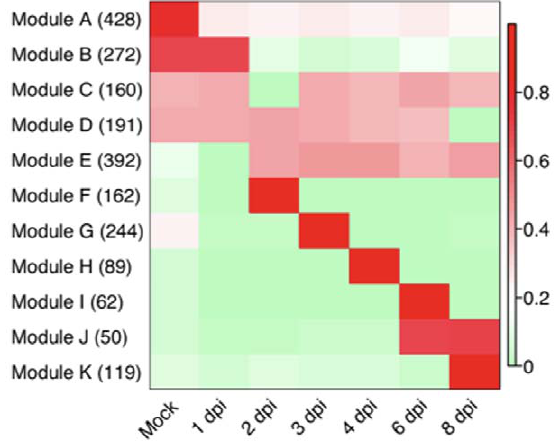
Figure 6. Heat map of eigengenes representing each gene module. The mock control and post-infection time points are represented in columns and the eigengenes for each of the 11 identified coexpression modules [49] are presented in rows. The numbers of genes in each module are given in parentheses. The eigengene values, which range from 0 to 1, are a measure of centrality and indicate the relative expression levels of all genes in the module (see Materials and Methods). dpi, days